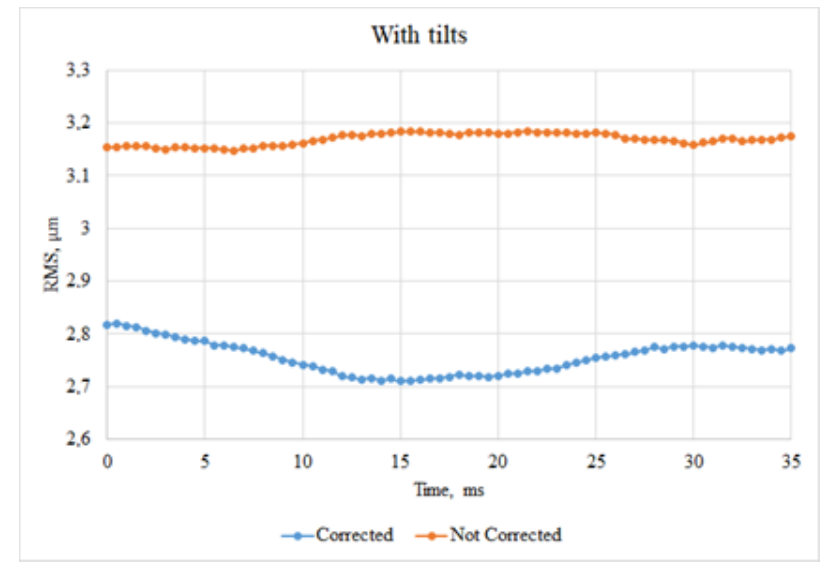
Figure 8. Residual RMS changes over time; full set of aberrations.